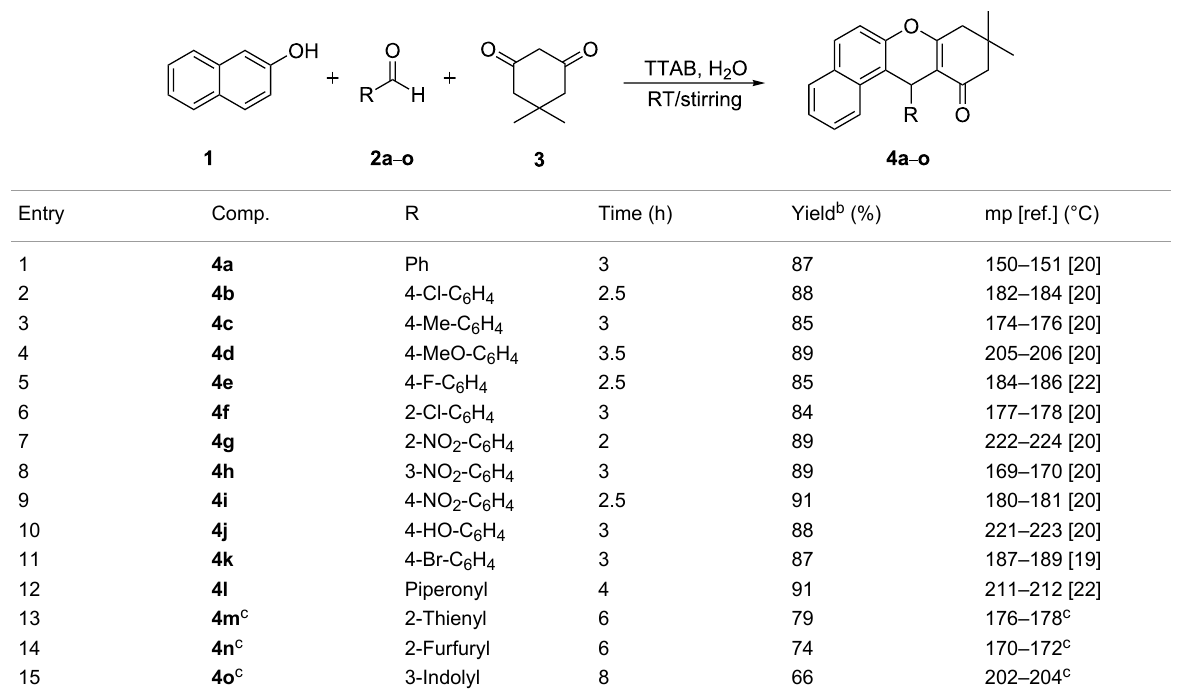
Table 2: Synthesis of 12-aryl-8,9,10,12-tetrahydrobenzo[ a ]xanthen-11-ones. a